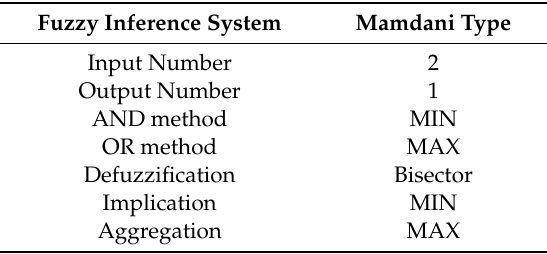
Table 3. The particulars of fuzzy